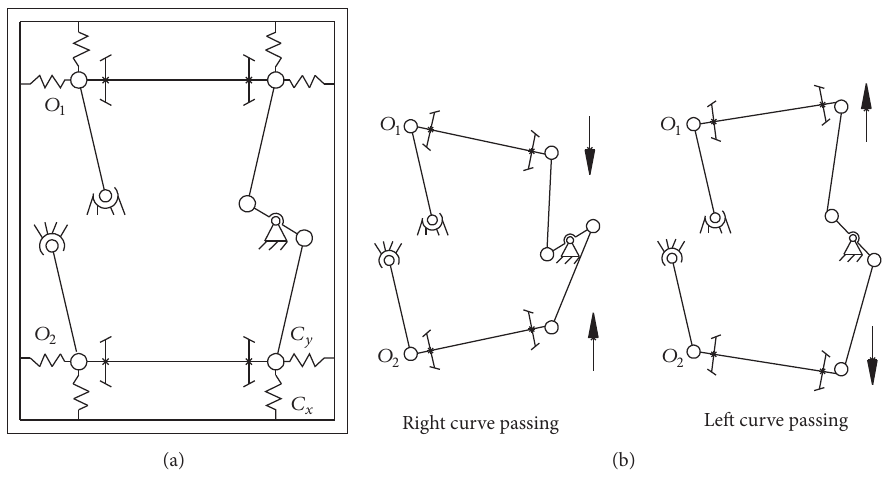
Figure 2: Diagram of asymmetric radial bogie (a) mechanism and (b) curve negotiation mechanism.